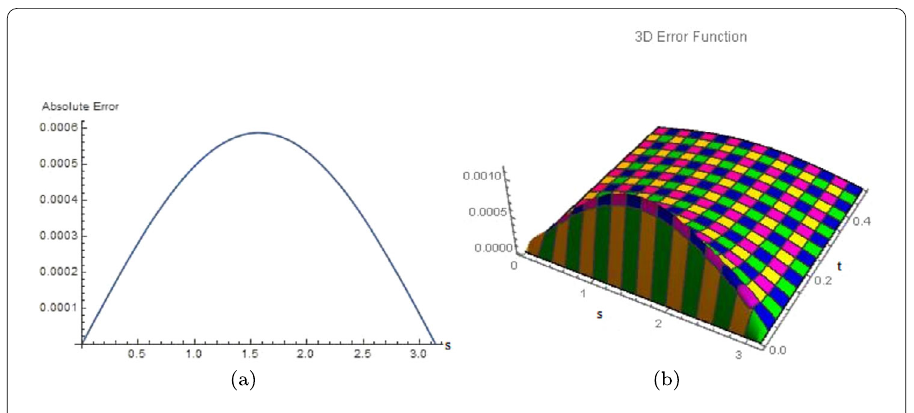
, t = 0.5 for Example 1 60